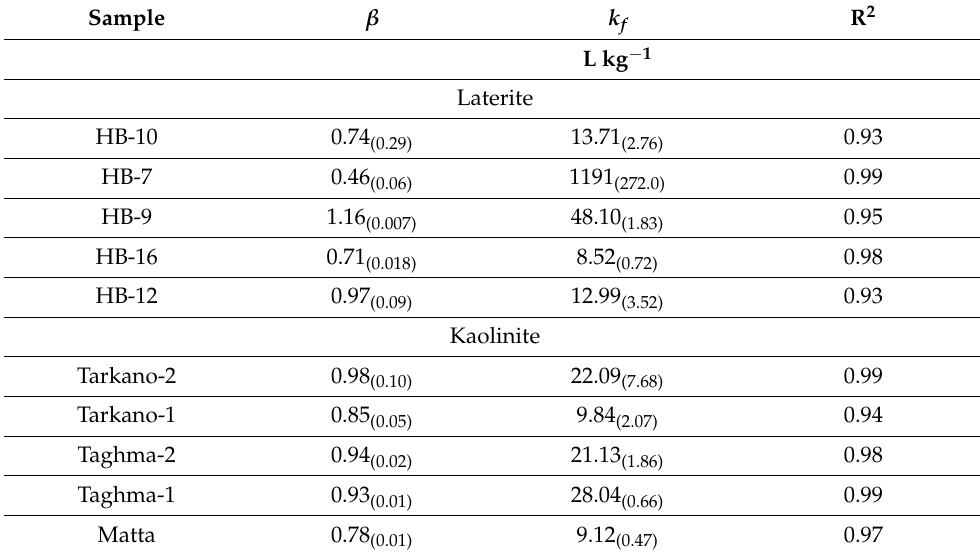
Table 2. Fitted Freundlich adsorption model parameters for laterite and